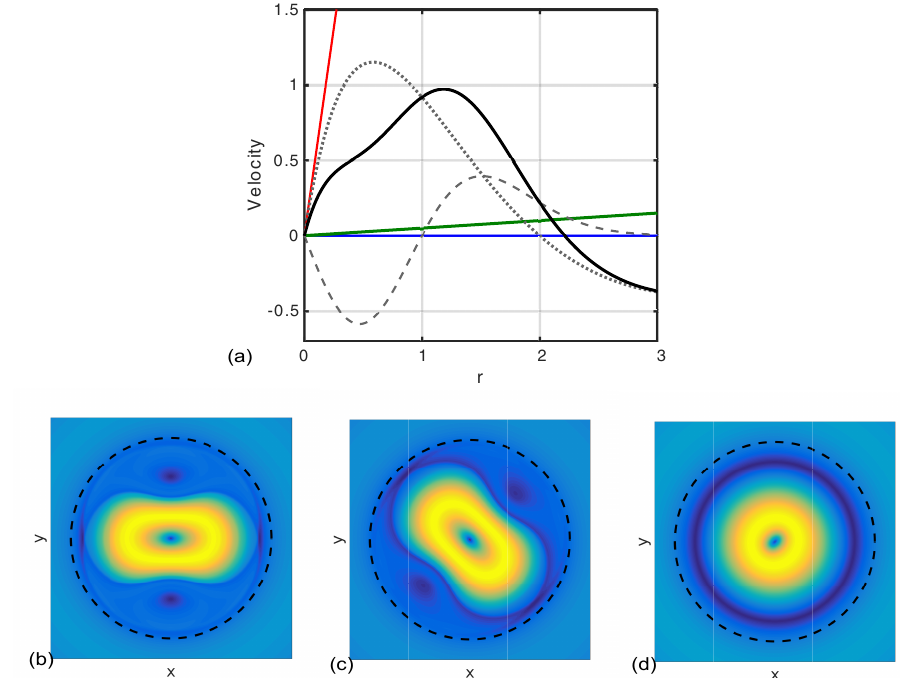
Figure 6. Some illustrative parameter choices for the kinematic model. (a) A representation of the mean flow azimuthal velocity (dotted line), the azimuthal velocity of wave 2 for the stationary case along λ = 0 (dashed line), the total azimuthal velocity along λ = 0 (solid line), the phase velocity for ω 2 = 0 . 1 (green line) and the phase velocity for ω 2 = 4 π (red line); (b) representation of the M function for a kinematic model considering a mean flow ( a = 2) plus a stationary wave 2 ( d = η 2 = 1); (c) the same as (b) for a rotating wave 2 with ω 2 = 0 . 1; (d) the same as (b) for a rotating wave 2 with ω 2 = 4 π